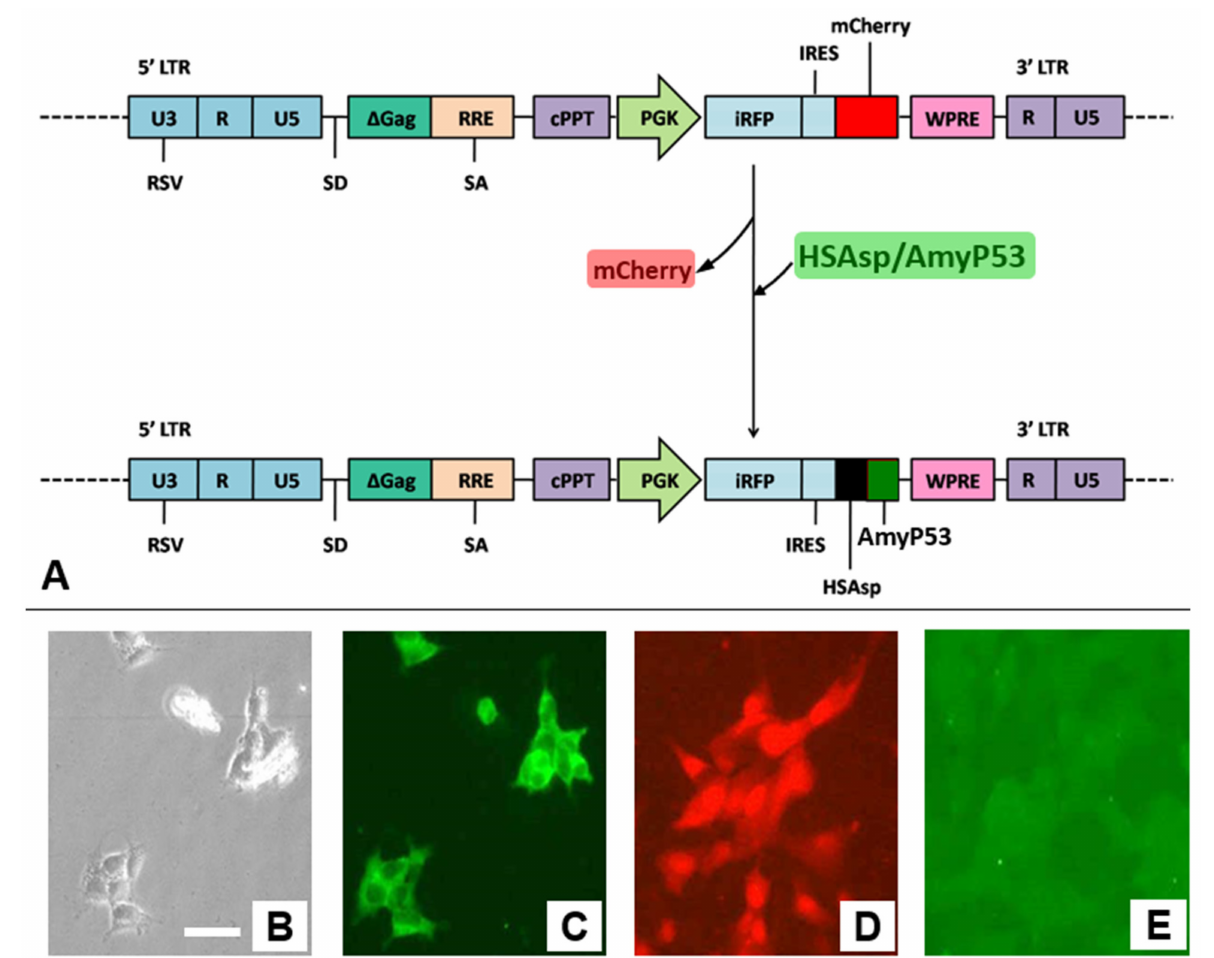
Figure 1. Specific detection of AmyP53 peptide in transfected cells. ( A ) Genetic construction used for engineering SH-SY5Y- AmyP53 cells and control SH-SY5Y-mCherry cells. ( B ) Phase contrast micrograph of SH-SY5Y-AmyP53 cells. ( C ) Cell surface immuno-labeling of SH-SY5Y-AmyP53 with the anti-AmyP53 peptide antibody (same field as in panel B ). ( D ) mCherry fluorescence of SH-SY5Y-mCherry cells. ( E ) Absence of detection of AmyP53 in control SH-SY5Y-mCherry cells. Scale bar: 25 µ